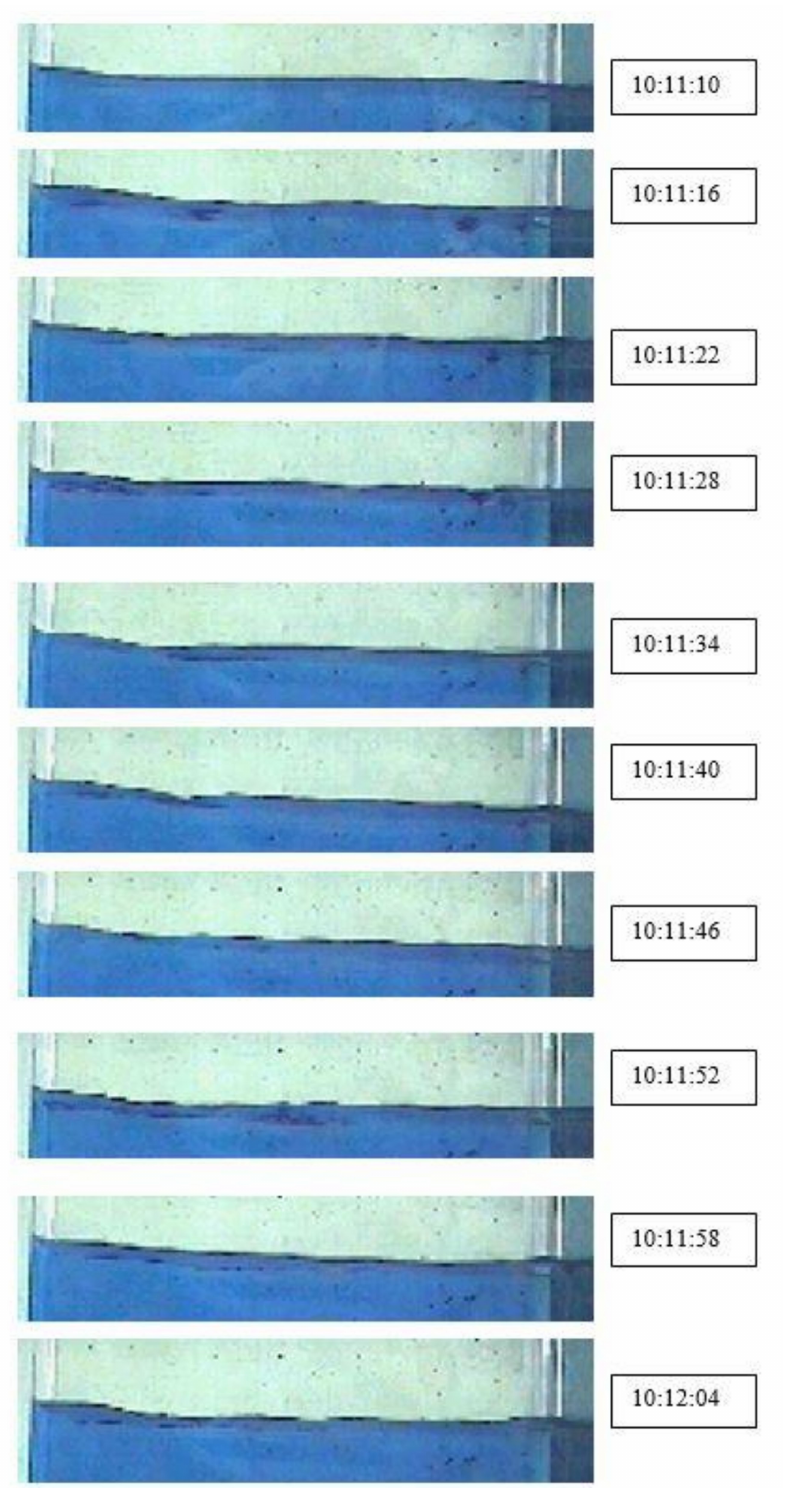
Figure 6. Various images of meniscus fluctuation were obtained from MATLAB